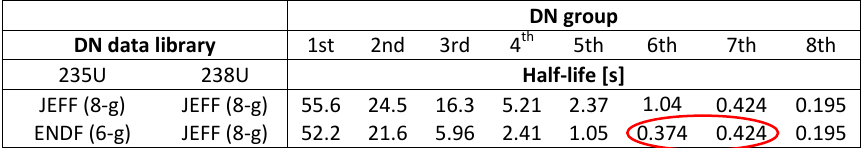
Table 3. Core averaged group half-lives calculated with MCNP using 8 groups format for both fissionable isotopes (first row) or combining 8 groups for 238 U and 6 groups for 235 U (second row). For the latter, the 6 th group has shorter half-life than the 7 th